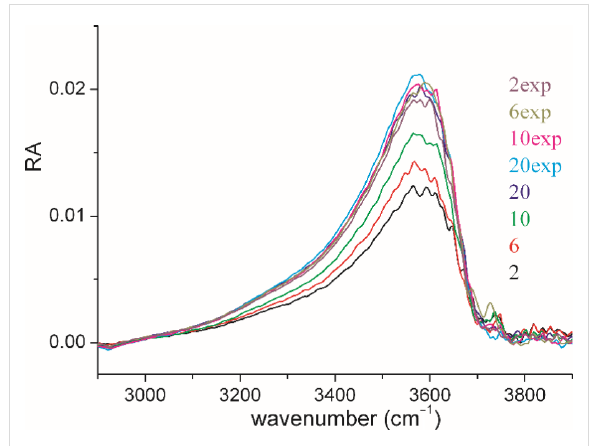
Figure 3: OH-stretching vibration ( ν (OH); 3600 cm − 1 ) for IRRA spec- tra of a flipper mechanophore monolayer during compression (2, 6, 10, and 20 mN/m) and expansion (20, 10, 6, 2 mN/m). The increase of in- tensity up to 20 mN/m indicates an increase of the effective layer